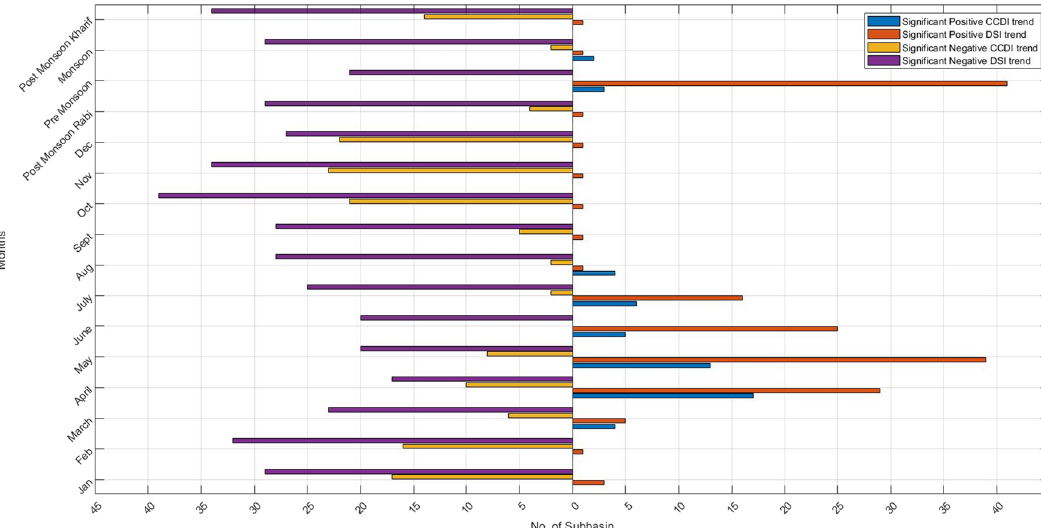
Figure 6. Horizontal bar chart depicting the number of sub-basins showing significant negative trends or significant positive trends for GRACE-DSI and CCDI. The left side is the number of sub-basins showing significant negative trends for CCDI (yellow) and GRACE-DSI (purple), whereas the right side is positive trends for CCDI (blue) and GRACE-DSI